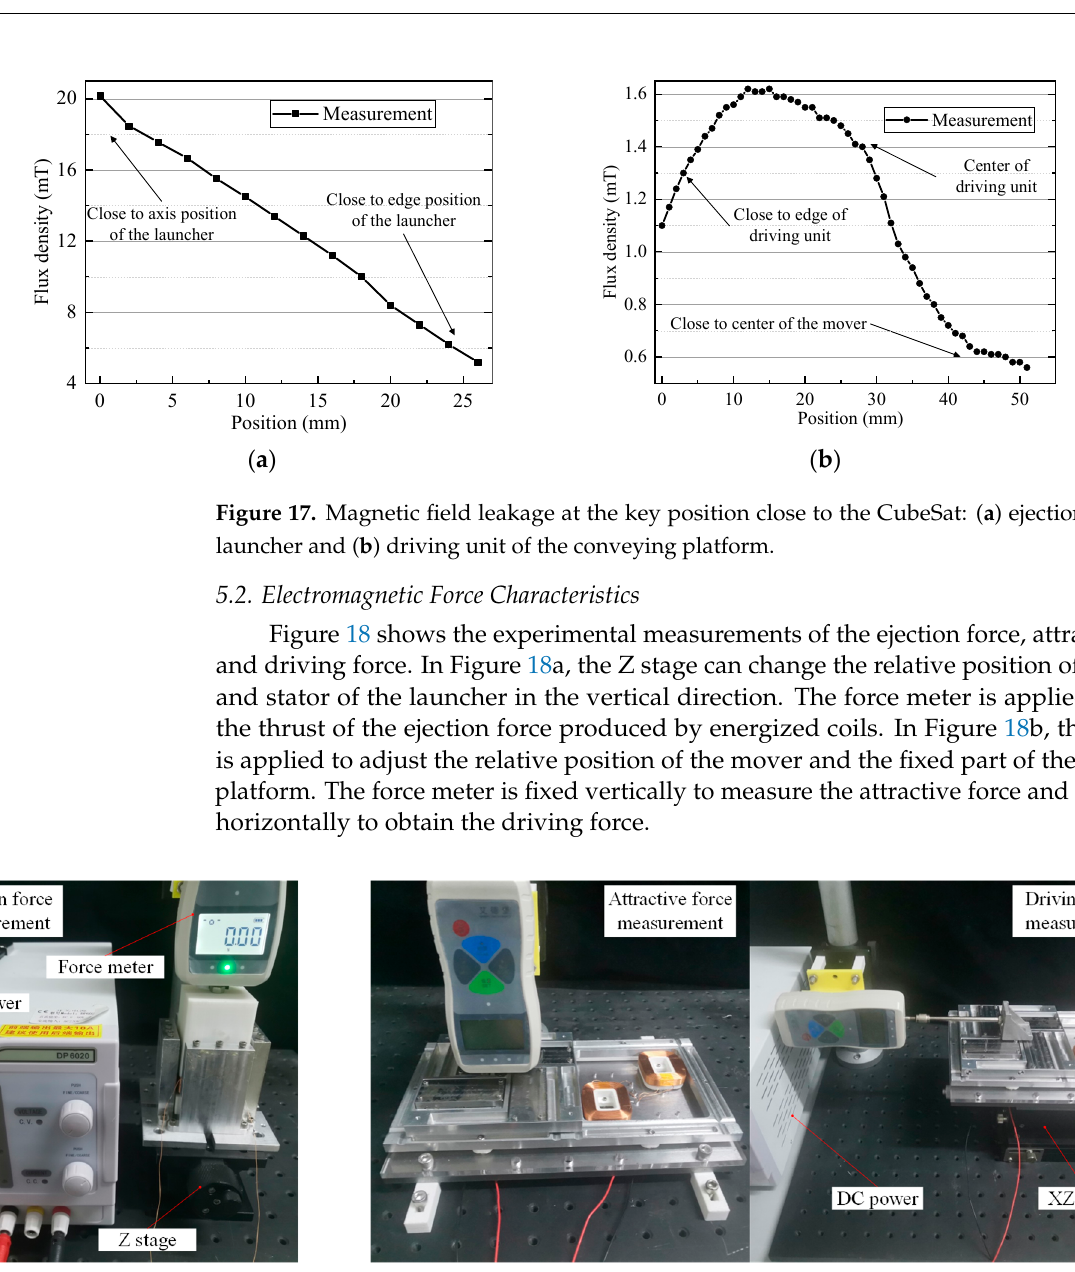
( b ) Figure 16. Magnetic field in the airgap center: ( a ) ejection unit and ( b ) driving unit. To evaluate the influence of magnetic field distribution on the CubeSat. Figure 17 illustrates magnetic field leakage at the key position close to the CubeSat. Due to the magnetic field enhancement of the double magnetic circuit, the magnetic flux leakage of the launcher is larger than that of the conveying platform. The magnetic field decreases from the center of the launcher to the edge region, as shown in Figure 17a. Due to the mutual superposition of the flux density leakage of the four ejection units, the magnetic field at the axis position of the launcher is the largest, at 20.17 mT. The flux density close